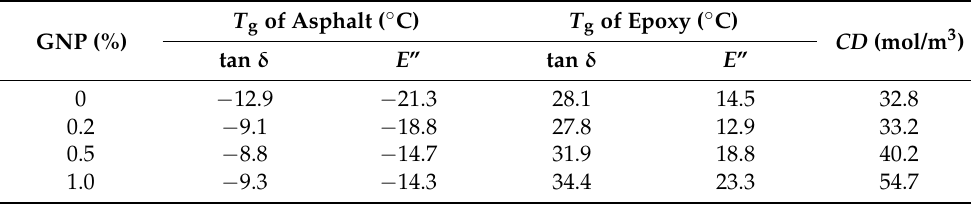
Table 5. T g s of epoxy and asphalt and crosslink densities for GNP-reinforced EABCs. GNP